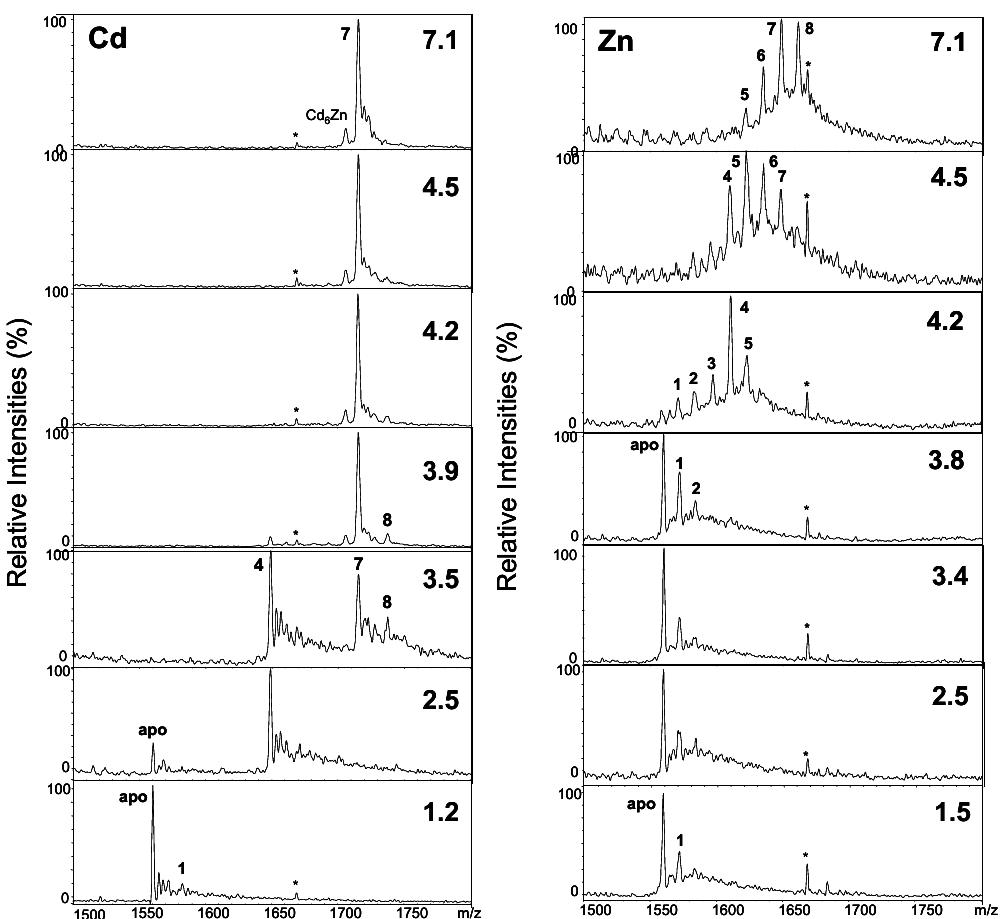
Figure 3. +5 charge state of raw, smoothed mass spectra showing speciation of Cd-wMT-2 and Zn-wMT-2 at different pH values (10 mM NH 4 HCO 3 , 10% MeOH). The peak labelled in both series with an asterisk is an unknown contaminant. The numbers indicate how many metal ions are bound in the respective species. All observed masses are compiled in Table 1.